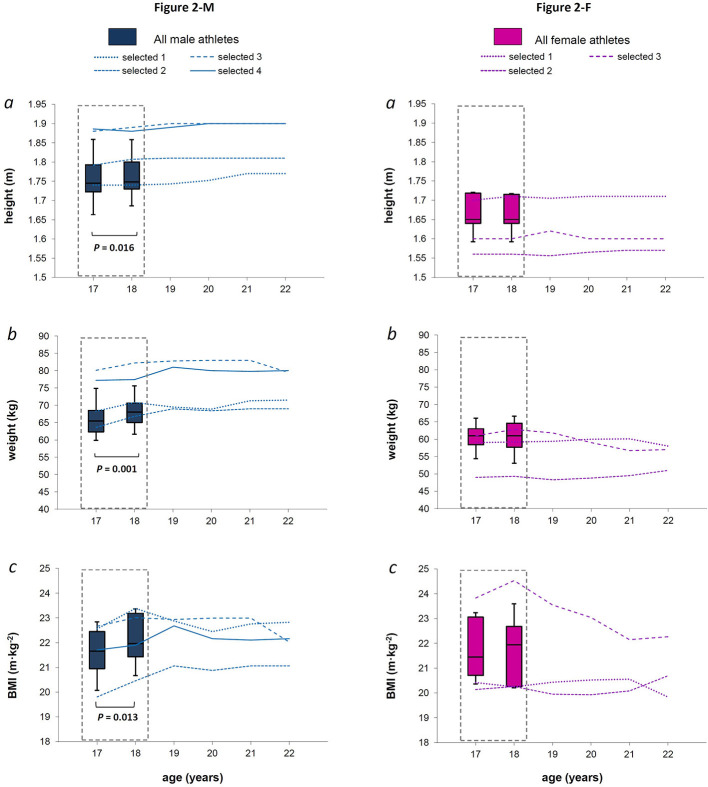
Figures 2-M and 2-F. For males and females (Figures 2-M and 2-F, respectively), the box plot represents medians, 9, 25, 75, and 90th percentiles of height, weight, and BMI (panel a, b, and c, respectively), measured over the late teenage period (data in dotted-lined boxes) in the entire group. The P-value refers to the statistical age effect during the late teenage period. In each panel, the line plots represent each selected athlete from 18 to 22 years of age.